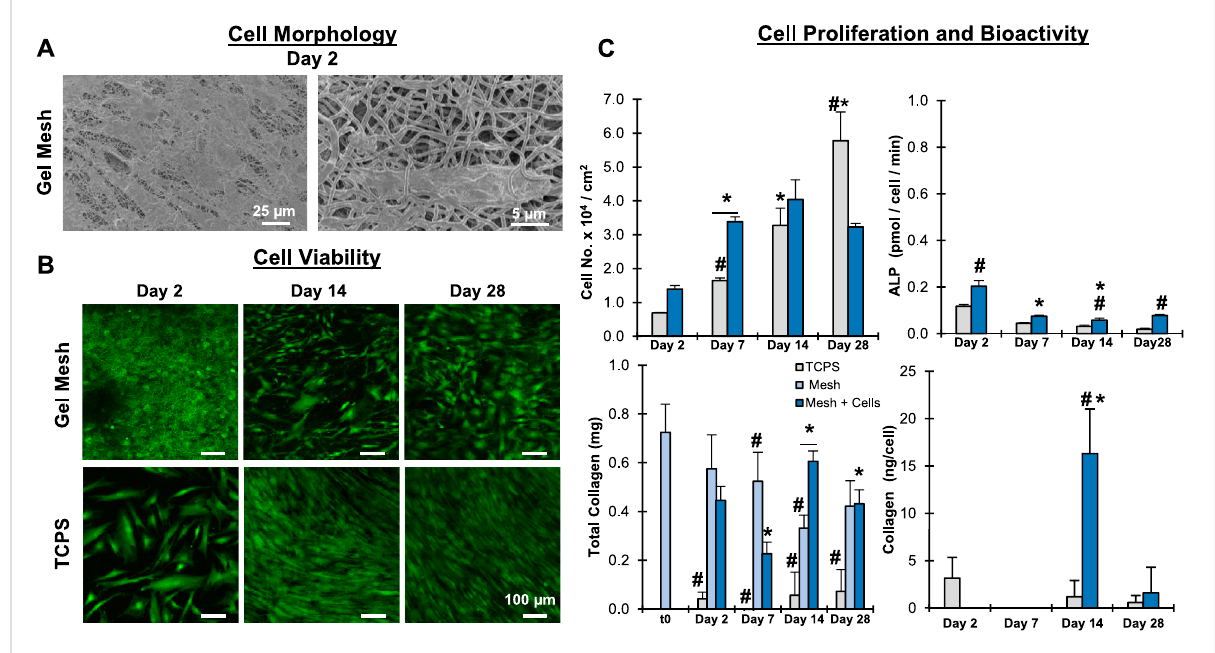
FIGURE 6 Mesh Biocompatibility: Stem Cells . Meshes were biocompatible and supported MSC attachment and growth. (A) Cell/matric interaction (Day 2,SEM,500x,2,500x). (B) CellViability (C) Cellproliferation,bioactivity,andmatrixstability( n =5).*= p < 0.05betweengroups.#= p <